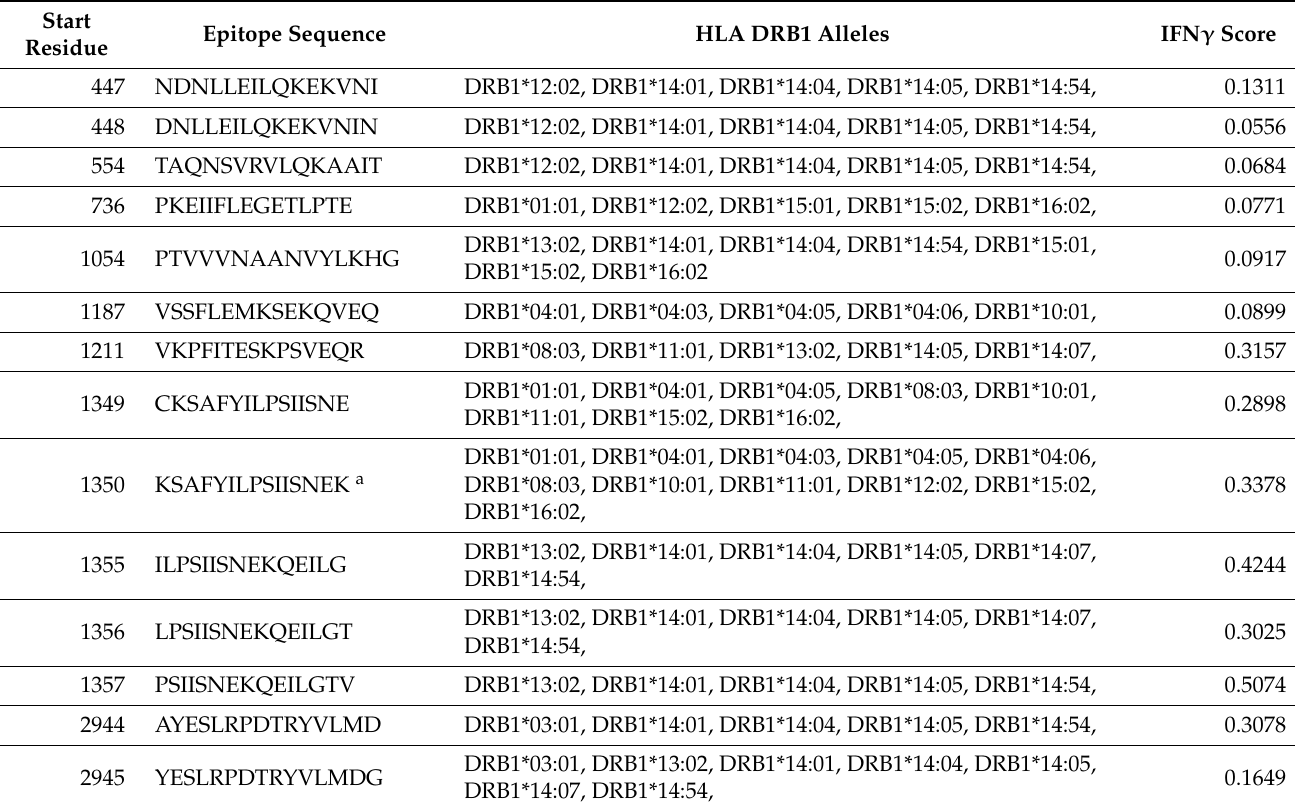
Table 5. List of 15-mer peptides predicted as promiscuous HTL epitopes and their IFN γ